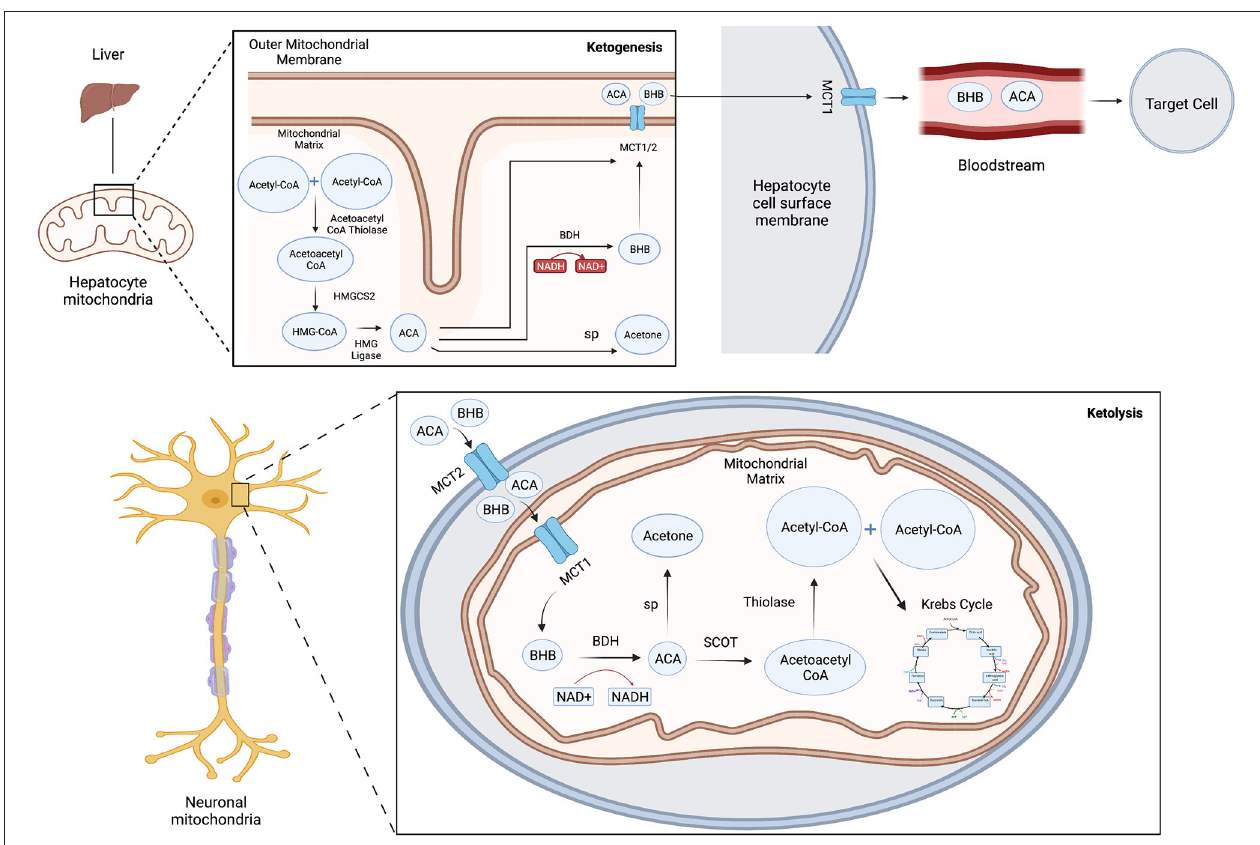
FIGURE 1 | Schematic model of ketone body metabolism. Ketogenesis: Acetoacetyl-CoA thiolase converts two acetyl-CoA molecules into acetoacetyl-CoA, which is combined with another acetyl-coA then converted into beta-hydroxy-methylglutaryl-CoA (HMG-CoA) by HMG-CoA synthase 2 (HMGCS2), which is metabolized into ACA and acetyl-CoA by HMG-CoA lyase. ACA is converted into BHB by β -hydroxybutyrate dehydrogenase (BDH) or converted into acetone by spontaneous decarboxylation (sp). ACA and BHB are transported by monocarboxylate transporters (MCT) out of the liver into the blood. Ketolysis: ACA and BHB enter